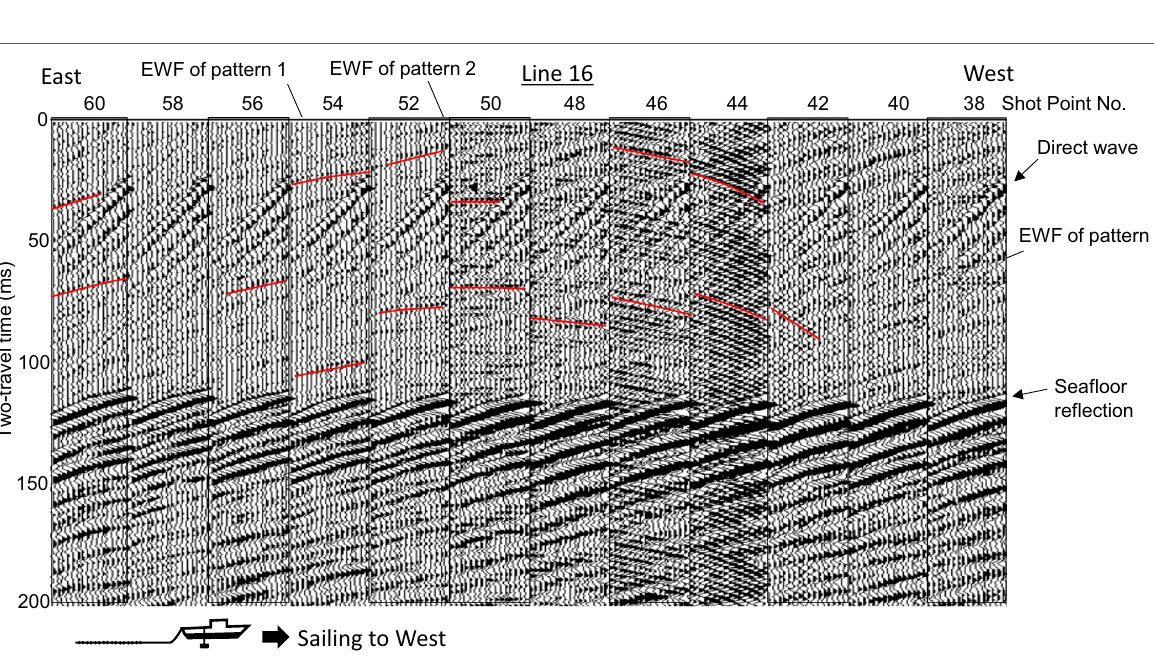
ing fractures (Kusumoto et al. 2001). Boles et al. (2001)